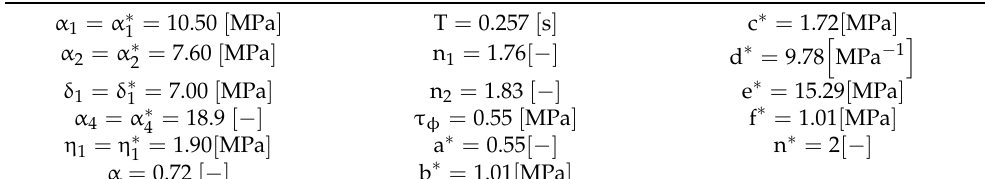
Table 1. HTFD material parameters for LIB.